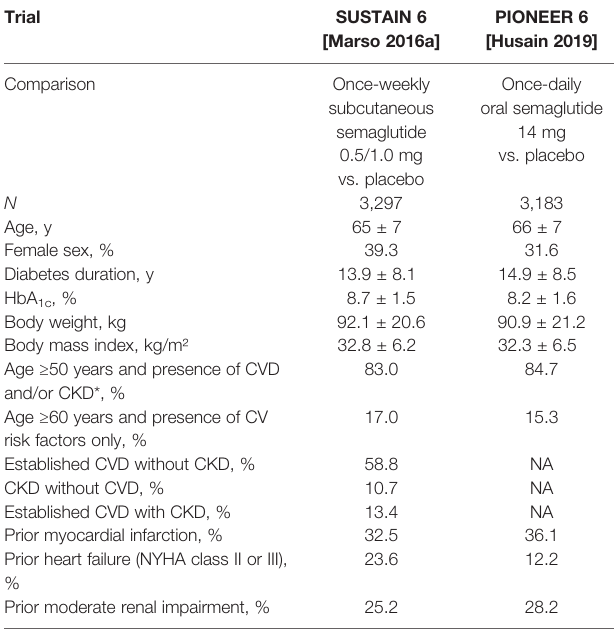
TABLE 1 | Baseline characteristics of patients in the SUSTAIN 6 and PIONEER 6 trials [Marso (6); Husain